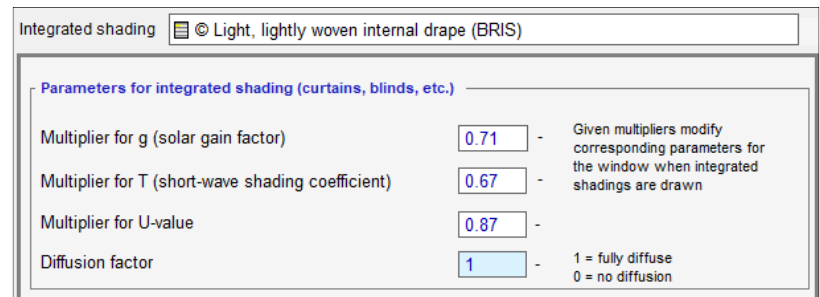
Figure 6. Details of lightly woven curtains used for internal shading.